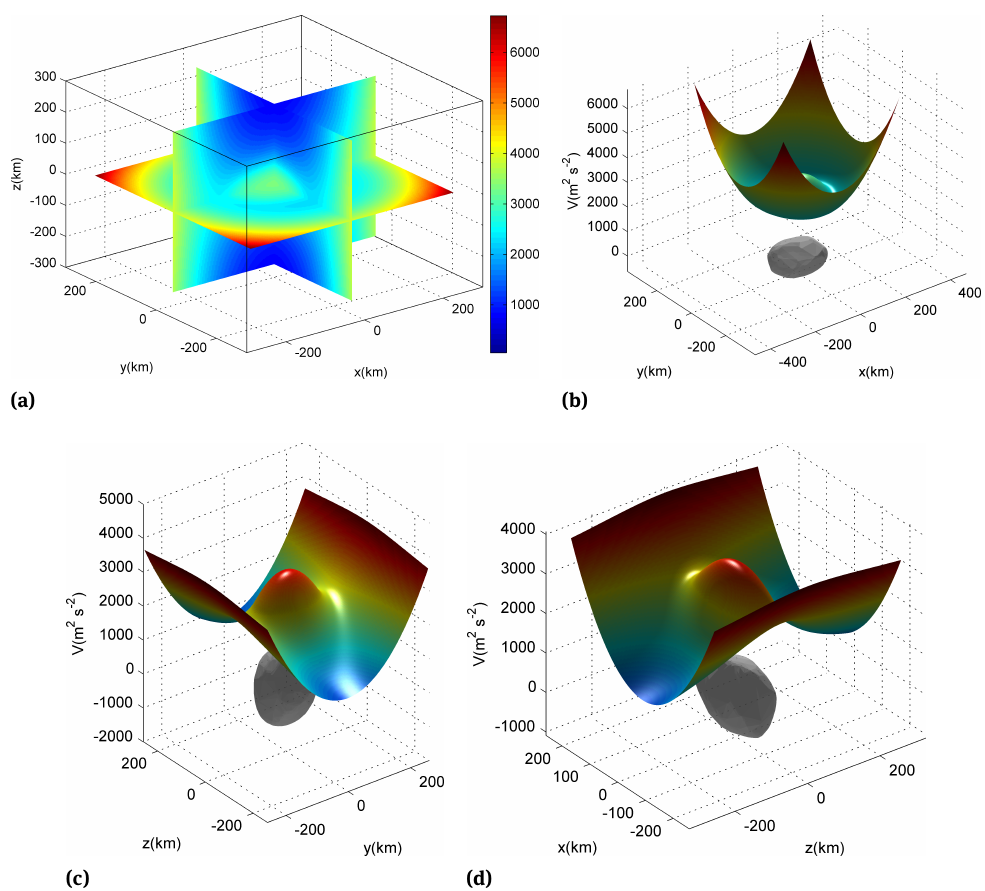
Figure 3. Effective potential of the asteroid 45 Eugenia. (a) 3D plot of the effective potential in the three coordinate planes of the body-fixed frame; (b) the effective potential in the equatorial plane and the 3D shape of 45 Eugenia; (c) the effective potential in the yz plane and the 3D shape of 45 Eugenia; (c) the effective potential in the zx plane and the 3D shape of 45 Eugenia.